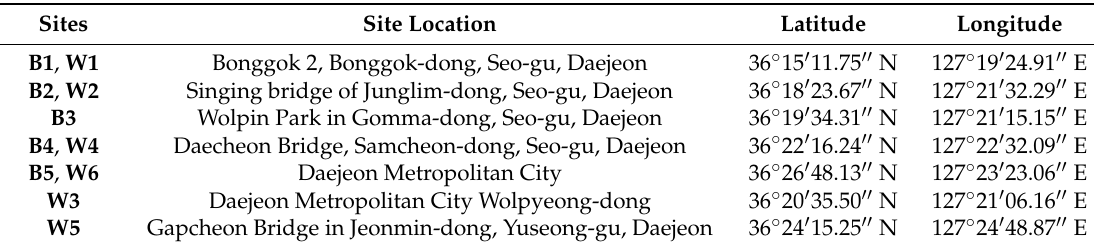
Table 1. Geographical location coordinates of water quality monitoring and biological sampling sites in Gap Stream, South